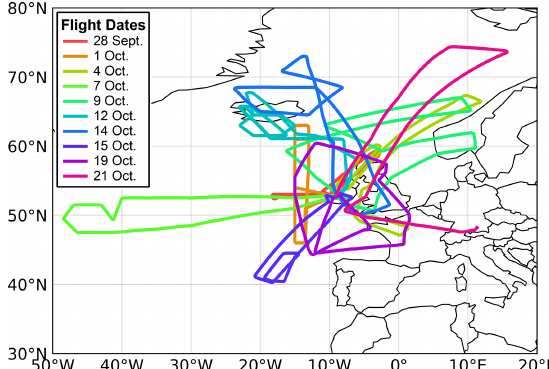
Figure 1. Map of 10 flight tracks carried out with the German HALO ( High Altitude and Long Range ) research aircraft from and to Shannon (Ireland) with one flight from Shannon to Oberpfaffen- hofen (Germany). The flights were conducted from 28 September to 21 October in 2017 in the frame of the WISE campaign (for details see